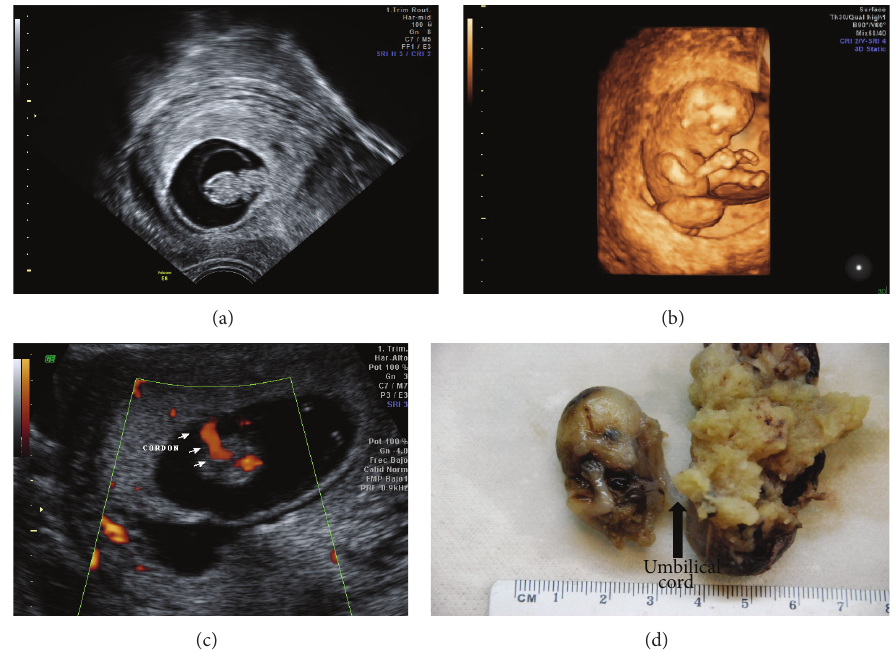
Figure 1: (a) The inferior body in the coelomic space. (b) Absence of the right leg. (c) Short umbilical cord of 5 mm. (d) Defect of the anterior and lower abdominal wall, with exposure of the intestine, liver, and spleen. The left leg was folded into the trunk. The upper extremities were